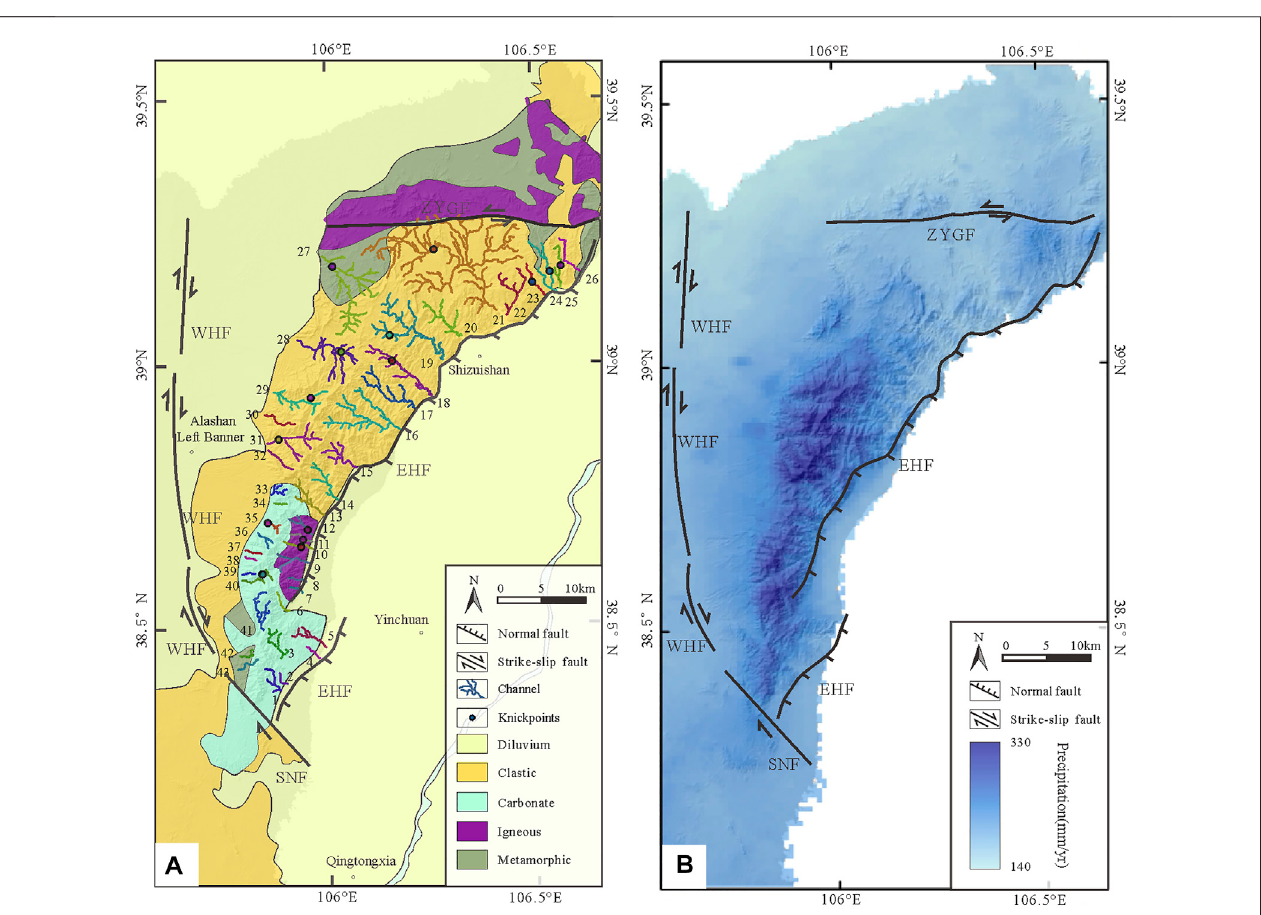
FIGURE7|(A) Thelithologyandknickpointsdistributionmap.Thedistributionoflithologyismodi fi edfromGeologicalMapofNingxiaHuiAutonomousRegion,the People ’ s Republic ofChina (2014). The knickpoints were identi fi ed from the χ -analysis of each stream. No knickpoints were located on lithological contacts or faults. (B) Mean annual rainfall shown over hillshade. Data comes from http://climatedataguide.ucar.edu/.